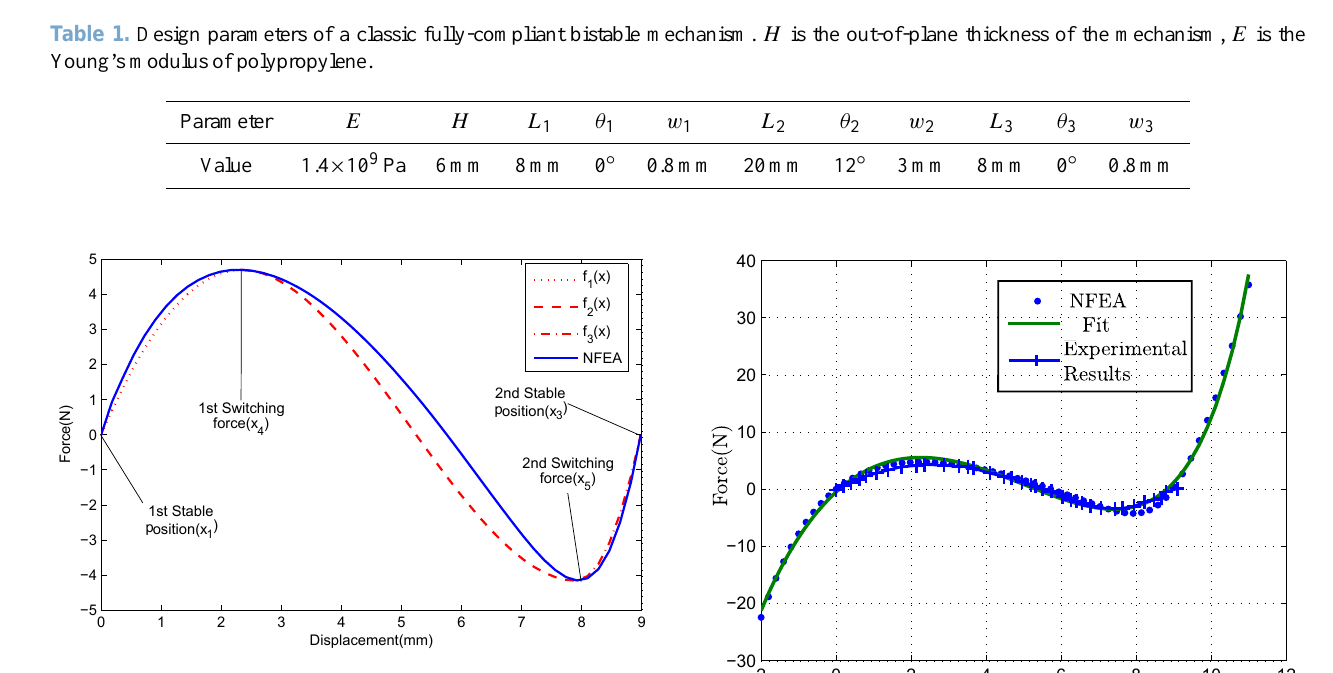
Figure 3. The comparision between the third-order polynomial and NFEA.